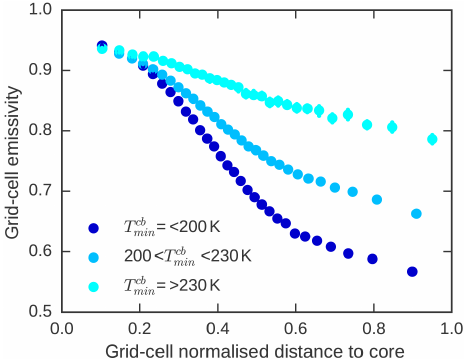
Figure 13. Median and standard error emissivity within cloud sys- tem as a function of the normalized distance to the convective core. Mature single-core systems are considered for three classes of con- vective depth represented by intervals in T cb min